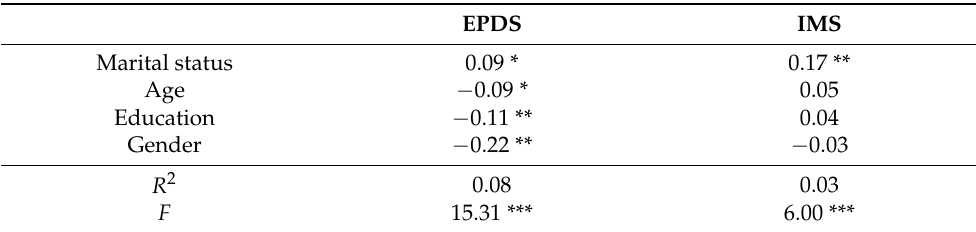
Table 3. Results from OLS regressions predicting EPDS and